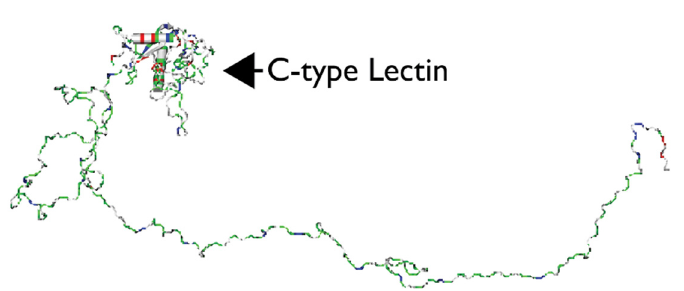
Figure 4. INTFOLD-predicted three-dimensional structures of S. purpuratus SpSM50 protein, in ribbon representation. The protocol for structure prediction is provided in references 27 and 29. Note that the SpSM50 protein possesses a surface-accessible C-type lectin carbohydrate binding domain, which presumably acts as a site for interaction with SpSM30B/C glycan groups.